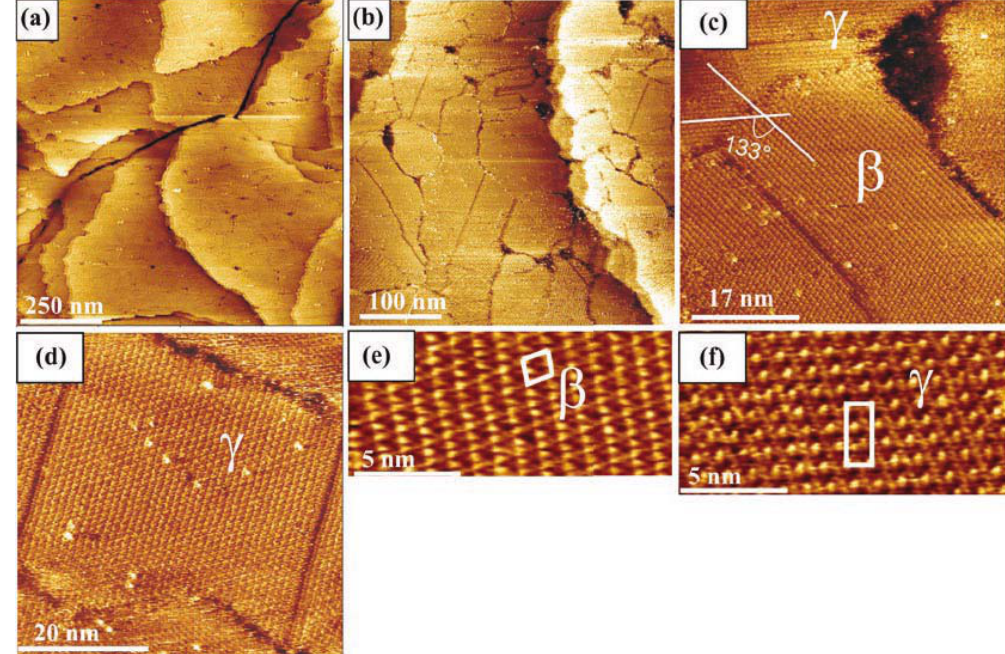
Figure 5. (a)-(f) constant-current STM images showing the gold surface after immersion in 100 μM ethanolic solution of BP2 at 343 K for 72 h. The rectangular unit cells of the (2 √ 3×3) and (5 √ 3×4) structures are marked in (e) and